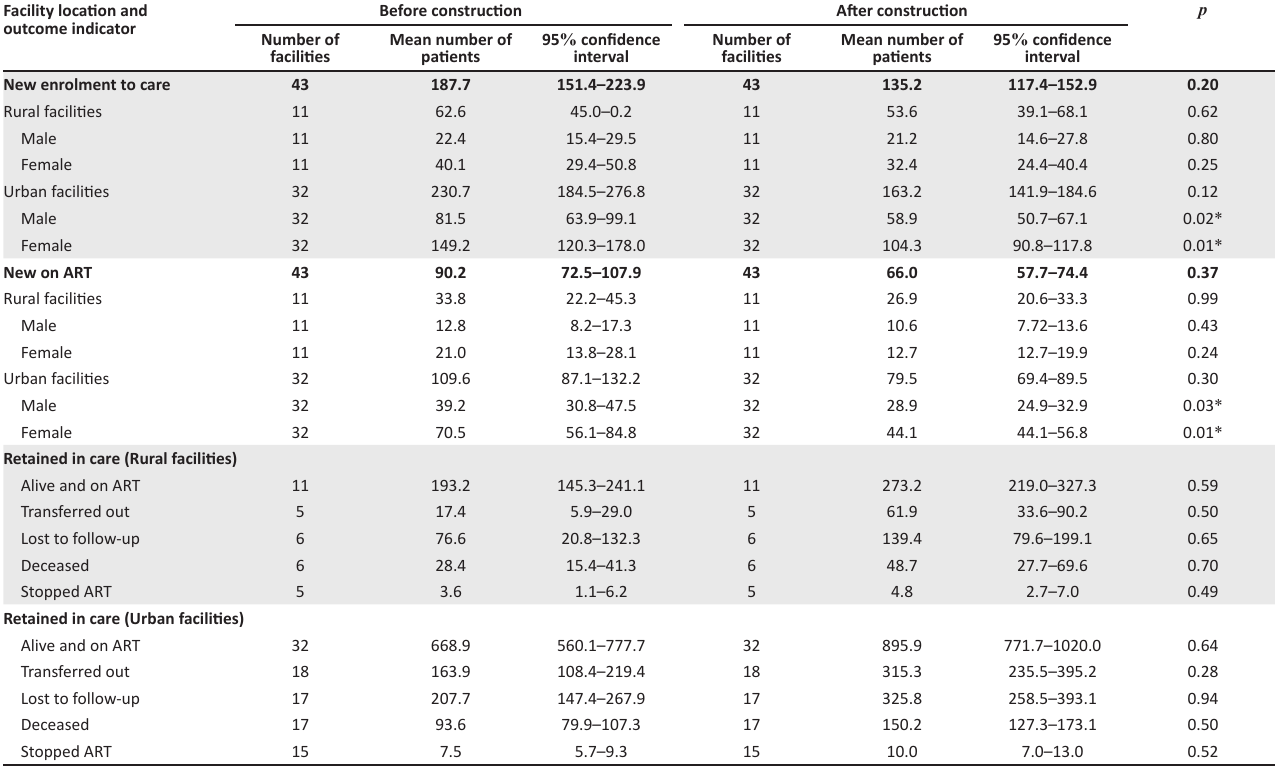
TABLE 1: Mean numbers of HIV-positive adults newly enrolled in care, initiated on antiretroviral therapy and retained in care before and after construction of HIV buildings in selected health facilities.